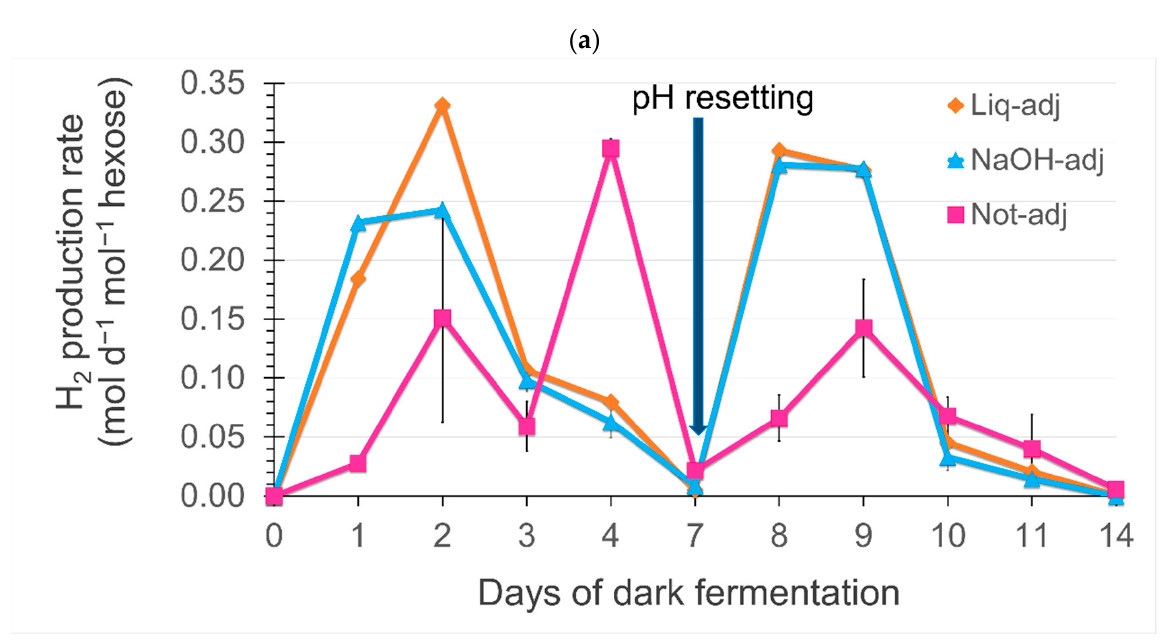
Figure 3. Daily rate of H 2 accumulation ( R ) in dark fermentation of differently prepared giant reed hydrolysates, i.e., Not-adj (not adjusted initial pH 5.3, pink squares); NaOH-adj (NaOH-adjusted initial pH 8.7, blue triangles); Liq-adj (black liquor-adjusted initial pH 8.7, orange diamonds); C represents the not treated and not hydrolyzed giant reed (control, NaOH adjusted pH 8.7, green circles): ( a ) Daily rate of H 2 accumulation per g VS; ( b ) Daily rate of H 2 accumulation per mole of hexose. The downward vertical arrow indicates the time of pH resetting of all reactors to their initial value with NaOH or black liquor depending on the treatment. Vertical bars represent the standard deviation (n = 3).